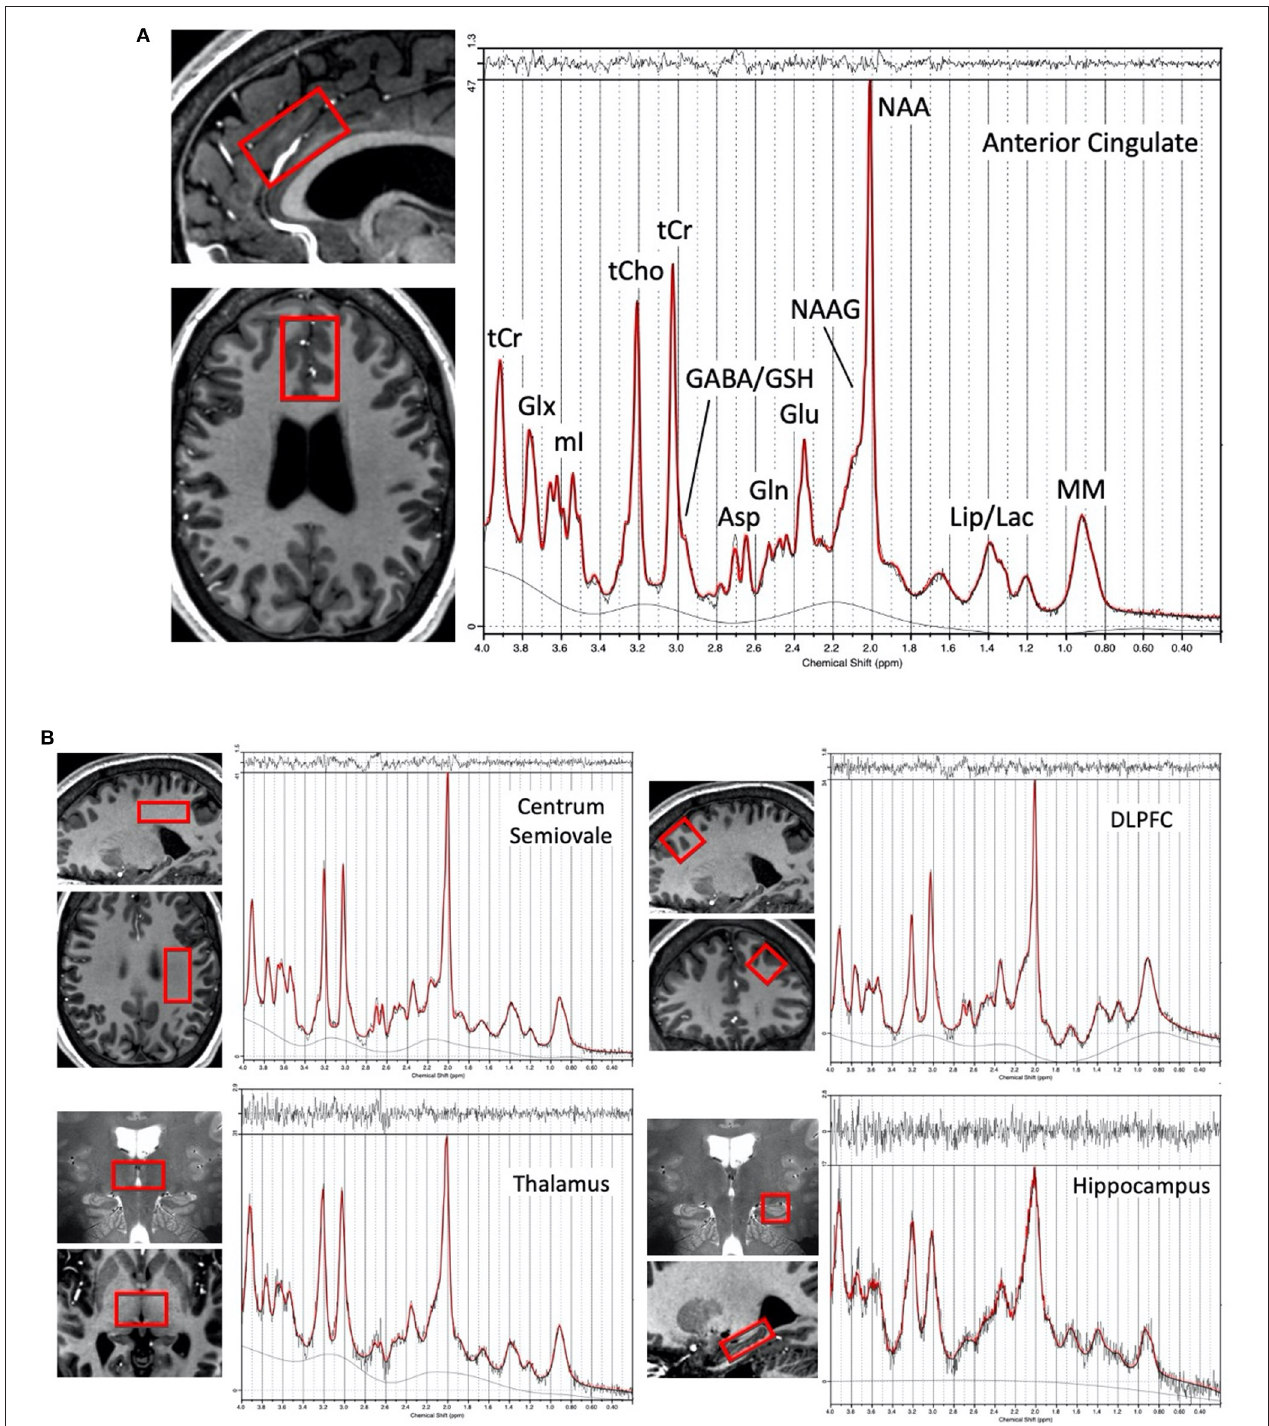
FIGURE 1 | (A) Representative voxel location chosen for the anterior cingulate cortex region in one subject (female, 28 yrs. old) and proton spectrum (LCModel output in red) with peak assignments indicated, (B) Representative voxel locations (overlaid in two planes on T 1 or T 2 -weighted images) from the left centrum semiovale, left dorsolateral prefrontal cortex, bilateral thalamus, and left hippocampus with a corresponding representative spectrum from each region.